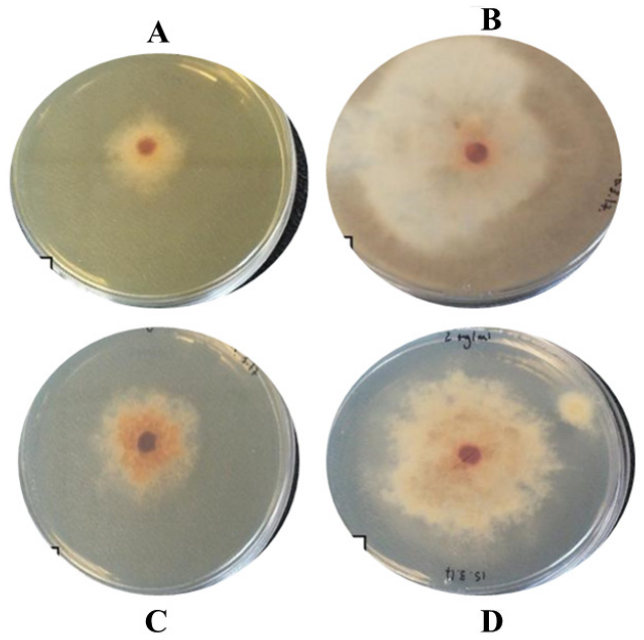
Figure 6. (A ) Spoilt apple fruits, ( B ) culture on PDA media, ( C ) growth of fungus on PDA media, ( D ) microscope, and ( E ) microscopic identification of fungus.